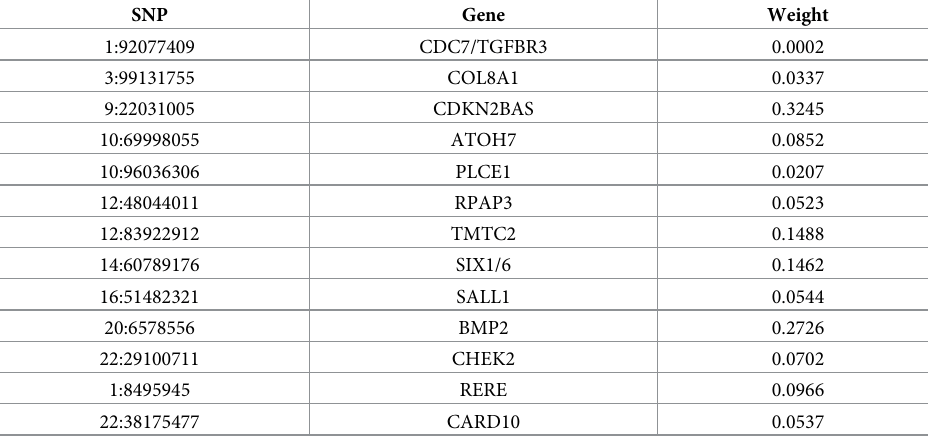
Table 2. Final 13 SNPs included in weighted genetic risk score based on high imputation quality (R 2 ) and match- ing risk alleles. SNP Gene